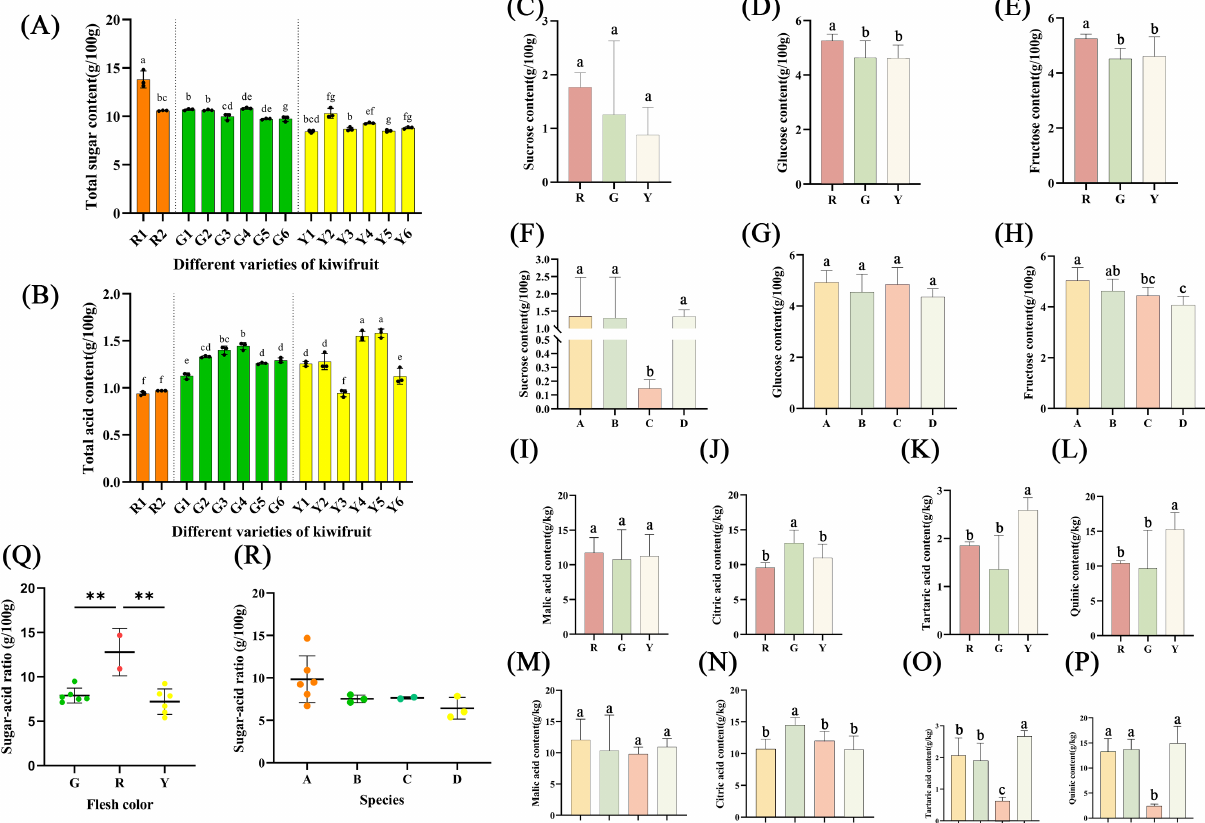
Figure 3. The results of total sugar content, total acid content, sucrose content, glucose content, fructose content, malic acid content, citric acid content, tartaric acid content and quinic acid content and sugar:acid ratio. ( A ) Total sugar content. ( B ) Total acid content. ( C ) Sucrose content in different flesh color. ( D ) Glucose content in different flesh color. ( E ) Fructose content in different flesh color. ( F ) Sucrose content in species. ( G ) Glucose content in species. ( H ) Fructose content in species. ( I ) Malic acid content in different flesh color. ( J ) Citric acid content in different flesh color. ( K ) Tartaric acid content in different flesh color. ( L ) Quinic acid content in different flesh color. ( M ) Malic acid content in species. ( N ) Citric acid content in species. ( O ) Tartaric acid content in species. ( P ) Quinic acid content in species. ( Q ) Sugar:acid ratio in different flesh color. ( R ) Sugar:acid ratio in species. ‘G’—green-fleshed kiwifruit. ‘R’—red-fleshed kiwifruit. ‘Y’—yellow-fleshed ki- wifruit. ‘A’— A. chinensis . ‘B’— A. chinensis var. deliciosa . ‘C’—A. eriantha. ‘D’— A. eriantha × A. chinensis . Values are means ± SD of three individual biological reproductions. Different lowercase letters indicated statistically significant differences (Duncan’s multiple range test, p < 0.05) among different kiwifruit cultivars. Statistical significance: ‘**’ p <